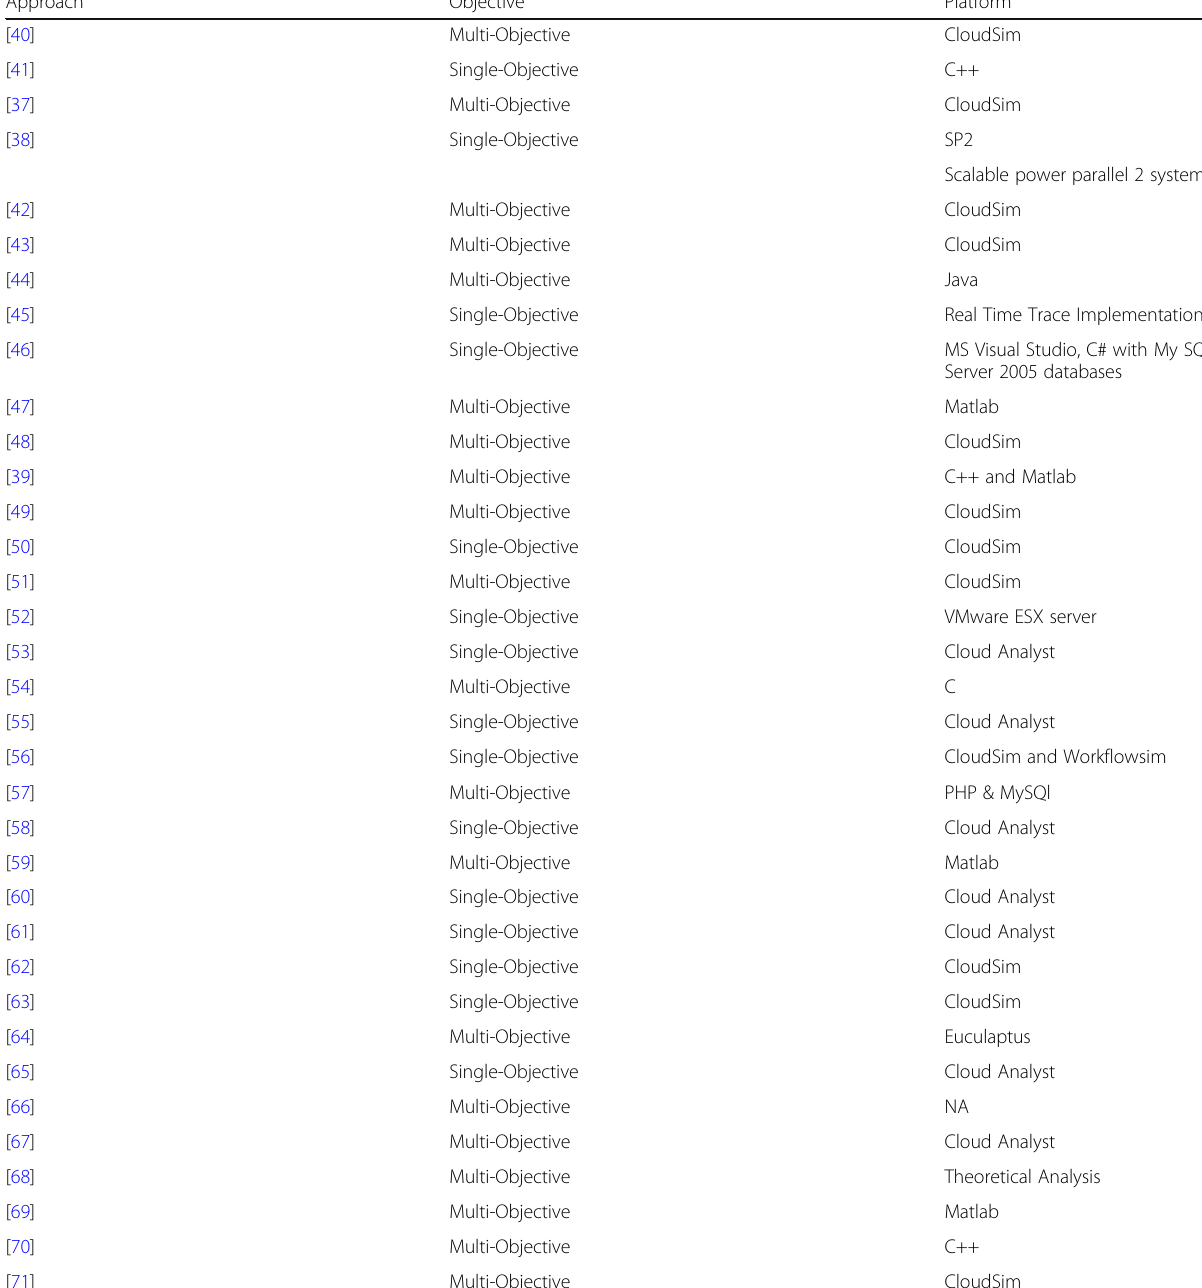
Table 3 Number of objective function (s) and implementation platform used in existing literature